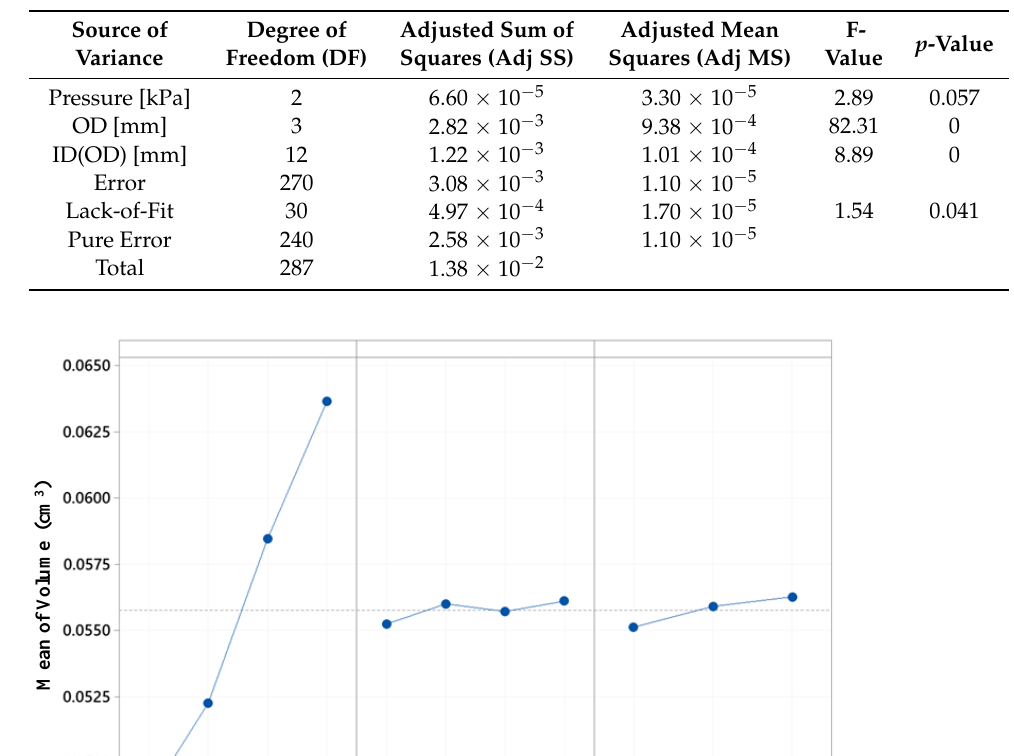
Table 3. Summary of generalized linear mixed model (GLM) nested for the lab testing experiment.